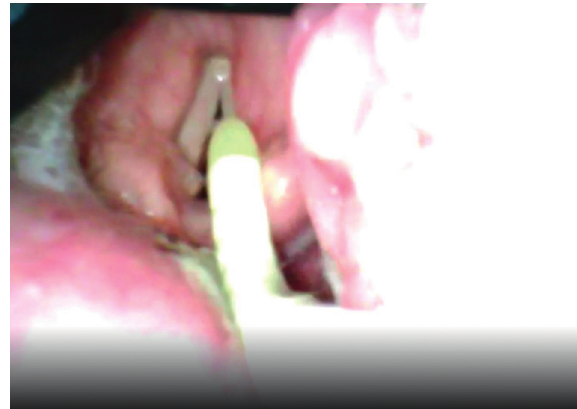
Figure 3: Flexible-tipped bougie in flexed